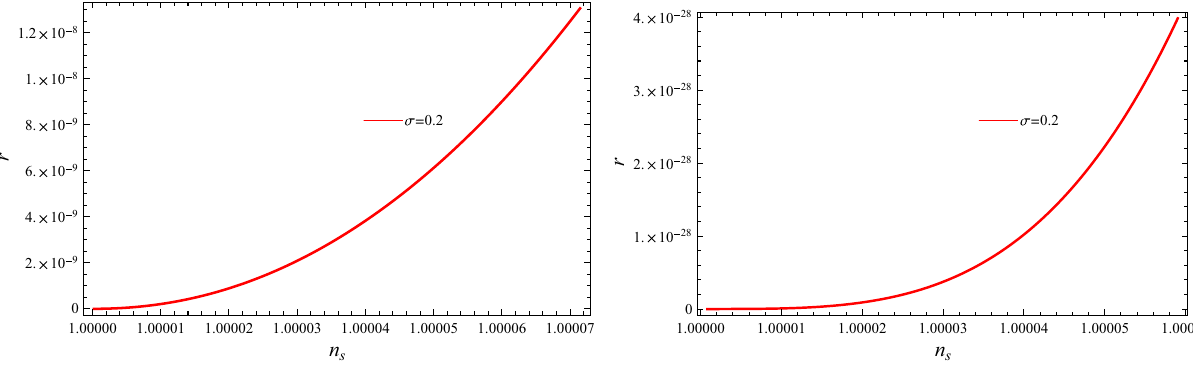
Fig. 4 Plot of r versus n s for GCG model in weak (left panel) and strong (right panel) dissipative regimes for negative potential with n = 1